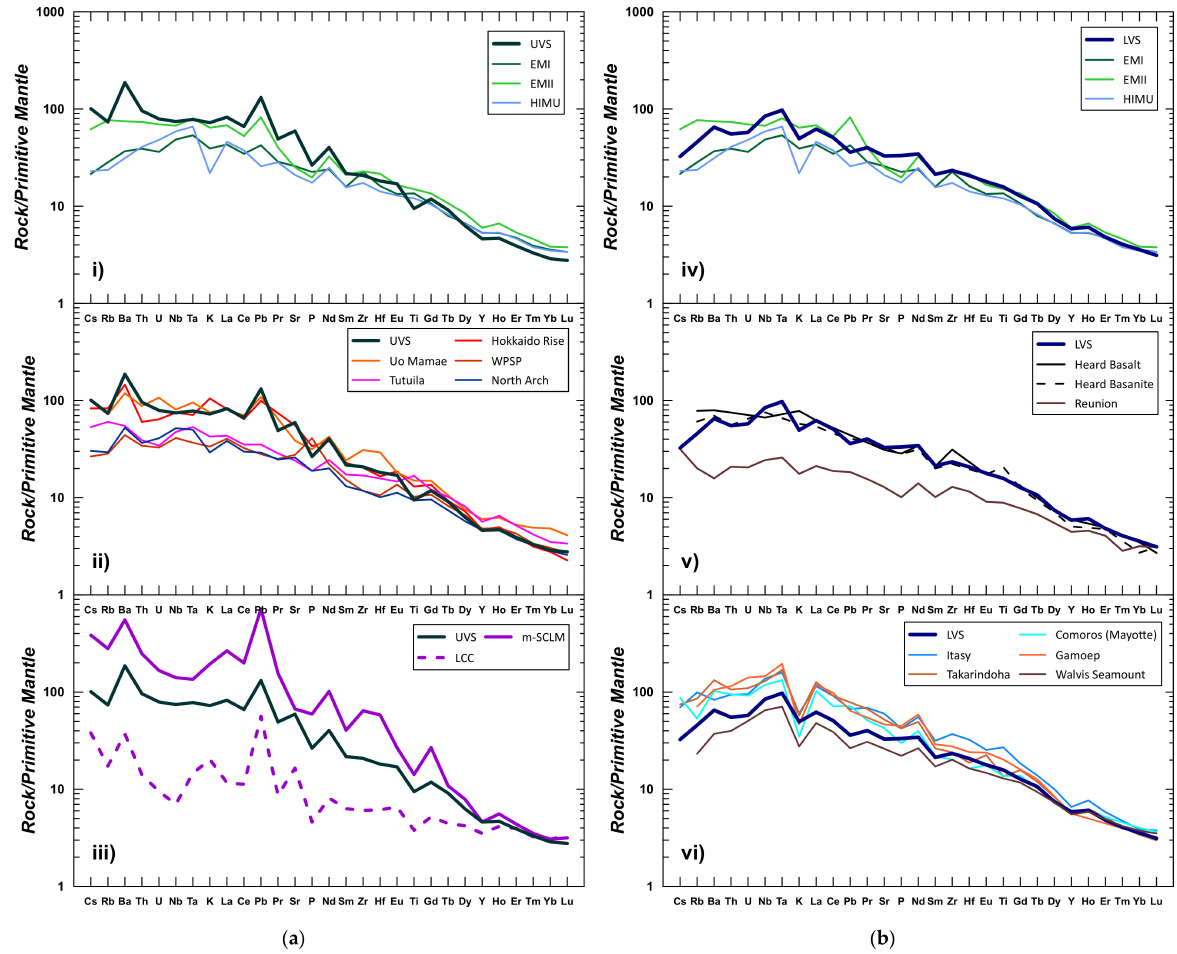
Figure 15. Primitive mantle normalized trace element abundance patterns for Christmas Island